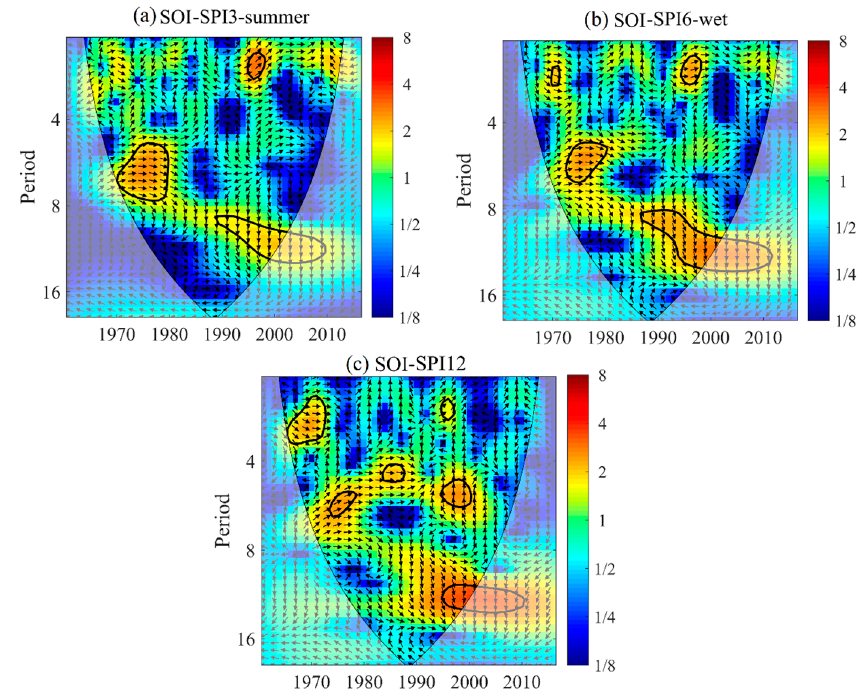
Figure 8. Cross-wavelet transforms of SOI and SPI3-summer ( a ), SOI and SPI6-wet ( b ), and SOI and SPI12 ( c ) time series. The thick black contours depict the 5% confidence level, and the black line is the cone of influence. Right-pointing arrows indicate that the two signals are in phase, while left-pointing arrows indicate anti-phase signals.